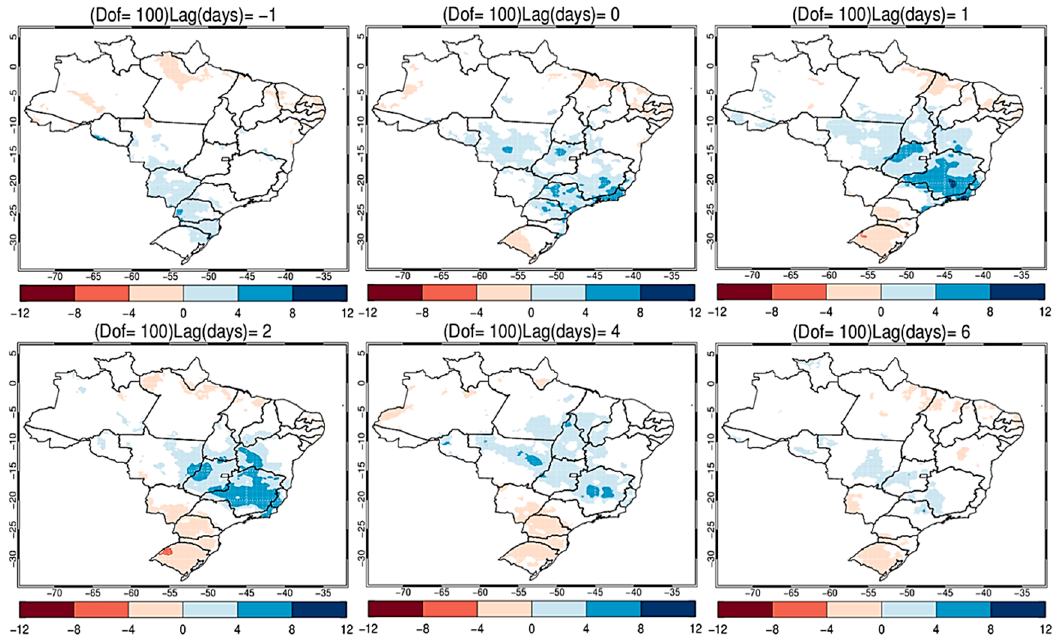
Figure 7. Lag composite of daily precipitation anomalies (mm/day) of SACZ events for AAO+. Shaded areas in blue (red) are for the positive (negative) values statistically significant at the 5% level, based on Student’s t -test. Dof is the degrees of freedom. The lags are indicated at the top of each figure.